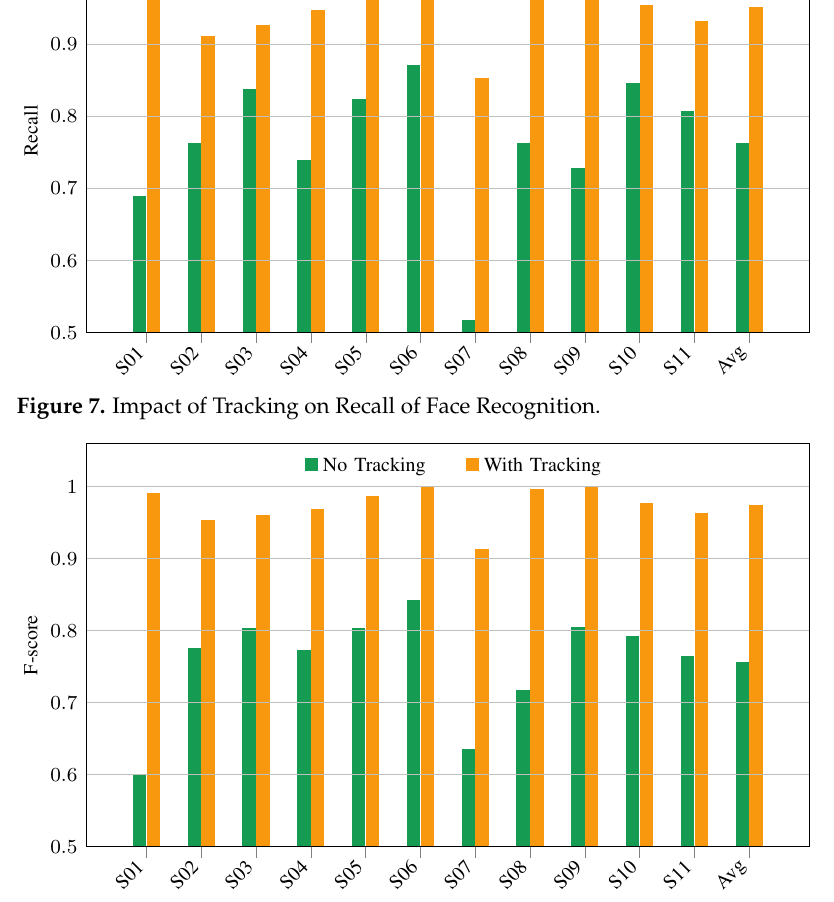
Figure 8. F-score results of the proposed framework with tracker-assisted and without Fig. 3. F-score results of the proposed framework with tracker-assisted and without tracking.